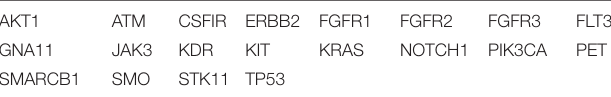
TABLE 1 | Mutated genes identified in the present case of mucinous